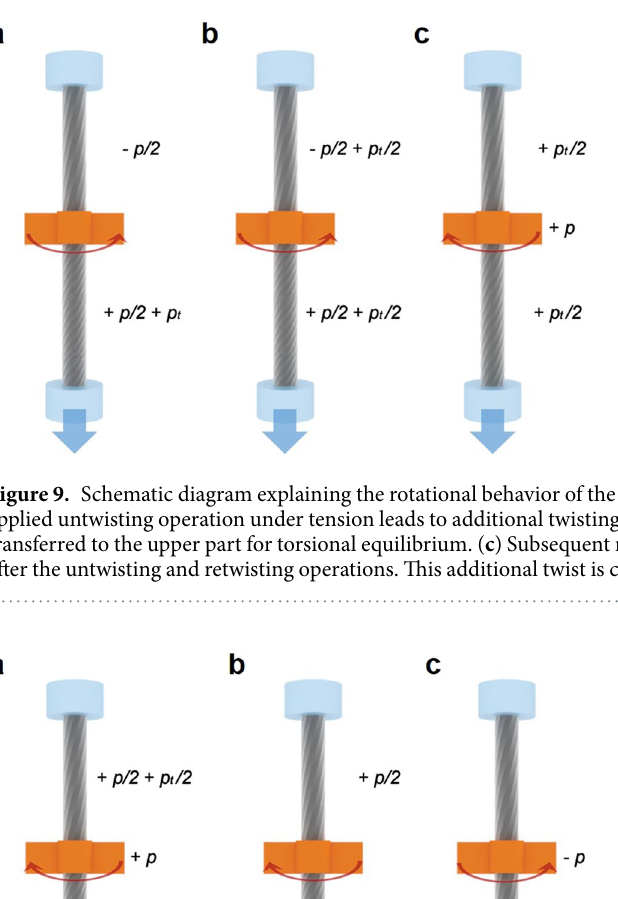
When an untwisting operation is applied to the CNT yarn at its center, during which tension is applied to the lower part of the CNT yarn, an additional twist is introduced to the lower part of the yarn due to the torque developed from the tension (Fig. 9a). This is consistent with the observations in Fig. 6a,b, i.e., asymmetric and opposite rotation of CNTs. For torsional equilibrium, half of the additional twist is then transferred to the upper part (Fig. 9b). When the CNT yarn is retwisted by the same amount of untwisting angle, a twist remains at both parts of the CNT yarn (Fig. 9c). Note that the detailed twist configuration (and thus CNT orientation) in Fig. 9c is different from that in Fig. 9a, even though a macroscopic rotation is cancelled by applying the same amount of untwist and retwist. The tension-induced twist can explain the hysteretic rotation of the two-ended tethered yarn in Fig. 2. Further retwisting and untwisting operations, which are the last two steps of the actuation (i.e., the right curve of the actuation curve in Fig. 2), are next considered, focusing on tension-induced twist. With further twisting operation ( + p ), the upper part of the CNT yarn is twisted ( + p /2) while its lower part is untwisted ( − p /2) (Fig. 10a), and is accompanied by a tension-induced untwist ( − p t ). Note that the tension-induced twist ( p t /2) remained as a result of the untwisting operation under tension in Fig. 9c. Half of the additional twist in the lower part is transferred to the upper part for torsional equilibrium, cancelling the addi- tional twist developed in the previous untwisting operation in Fig. 9b (Fig. 10b). Finally, the CNT yarn returns to its original configuration upon further untwisting (second untwisting) (Fig. 10c). Again, note that the twist con- figuration in Fig. 10c is different from that in Fig. 10a, even though macroscopic rotation is cancelled by applying